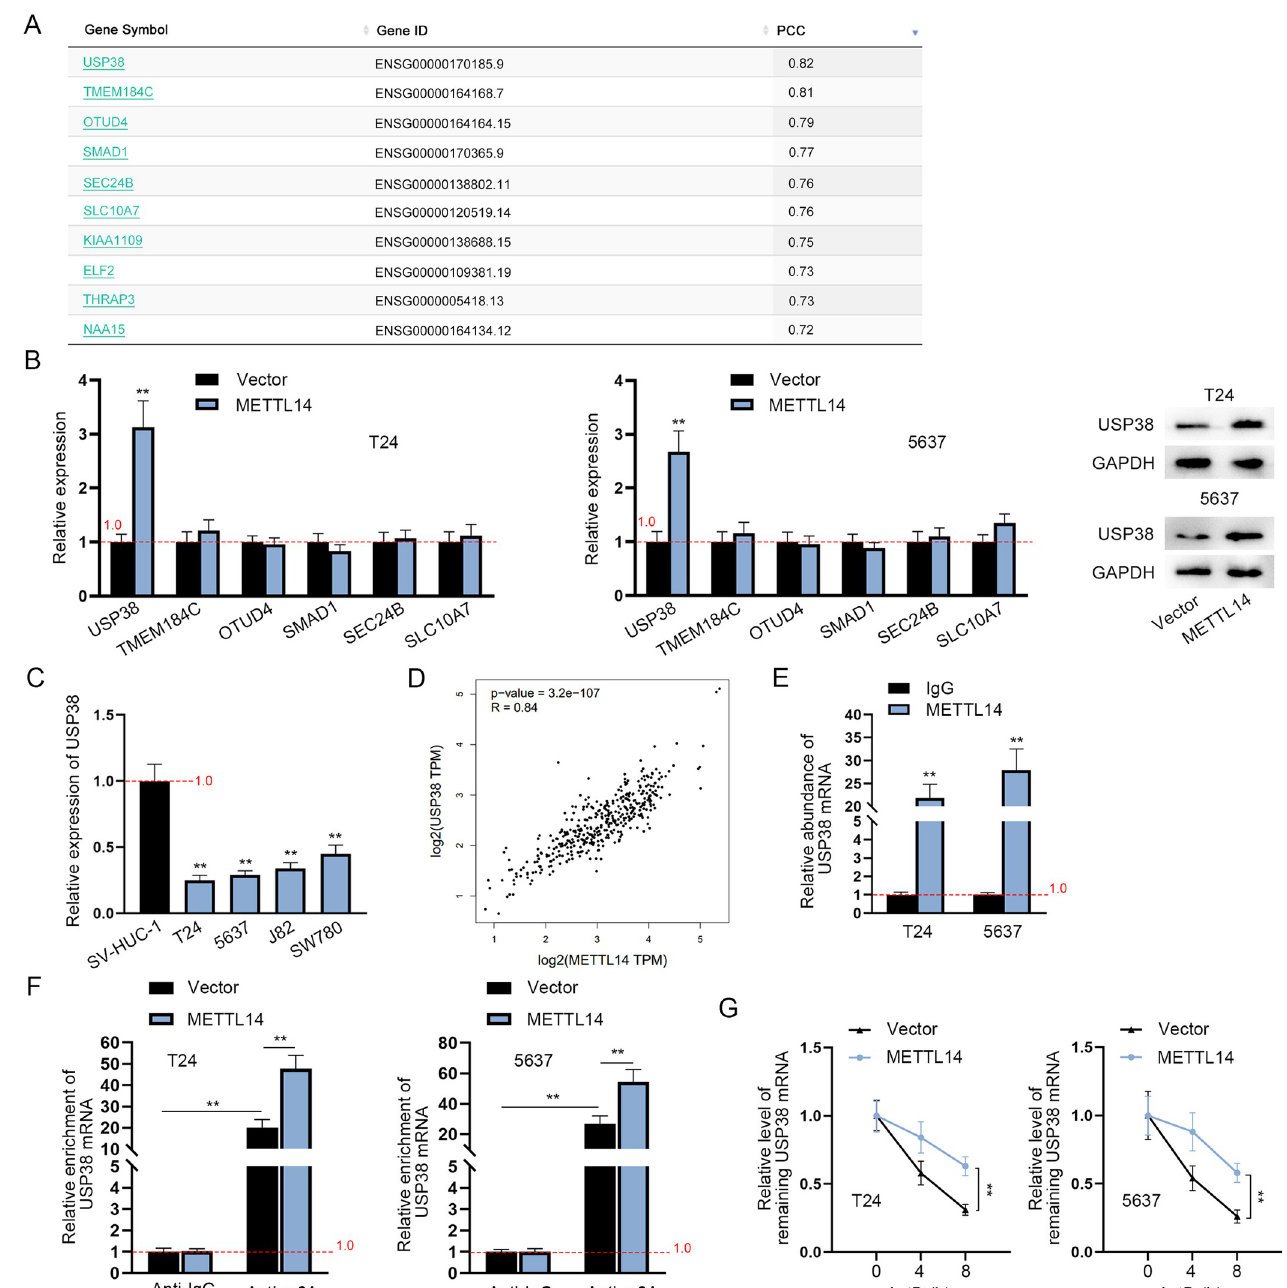
Fig 2. METTL14 stabilizes USP38 mRNA through m6A modification. A. GEPIA analysis of similar genes with METTL14 in BLCA. B. RT-qPCR was carried out to assess the relative expression of 6 similar RNAs with METTL14 (USP38, TMEM184C, OTUD4, SMAD1, SEC24B and SLC10A7) before and after the overexpression of METTL14 in BCa cells (left panels). (n = 3) Each bar represents mean; error bars represent SD. P values were determined by one-way ANOVA followed by Tukey’s test. Western blot of USP38 expression in BCa cells was shown (right panels). C. RT-qPCR was carried out to assess the relative expression of USP38 in SV-HUC-1 and BCa cell lines. (n = 3) Each bar represents mean; error bars represent SD. P values were determined by one-way ANOVA followed by Dunnett’s test. D. GEPIA predicted a positive correlation between METTL14 and USP38 mRNA in BLCA tissues. E. RIP assays were applied to explore the interaction between METTL14 and USP38 in BCa cells. (n = 3) Each bar represents mean; error bars represent SD. P values were determined by Student’s t test. F. Me-RIP assays were conducted to determine the influence of METTL14 on the m6A modification of USP38 mRNA. (n = 3) Each bar represents mean; error bars represent SD. P values were determined by two-way ANOVA followed by Tukey’s test. G. RT-qPCR was used in mRNA stability assays to assess the relative level of USP38 mRNA after the treatment of ActD with or without the upregulation of METTL14 in BCa cells. (n = 3) Each point represents mean; error bars represent SD. P values were determined by Student’s t test. �� P < 0.01. See also S4 Data.